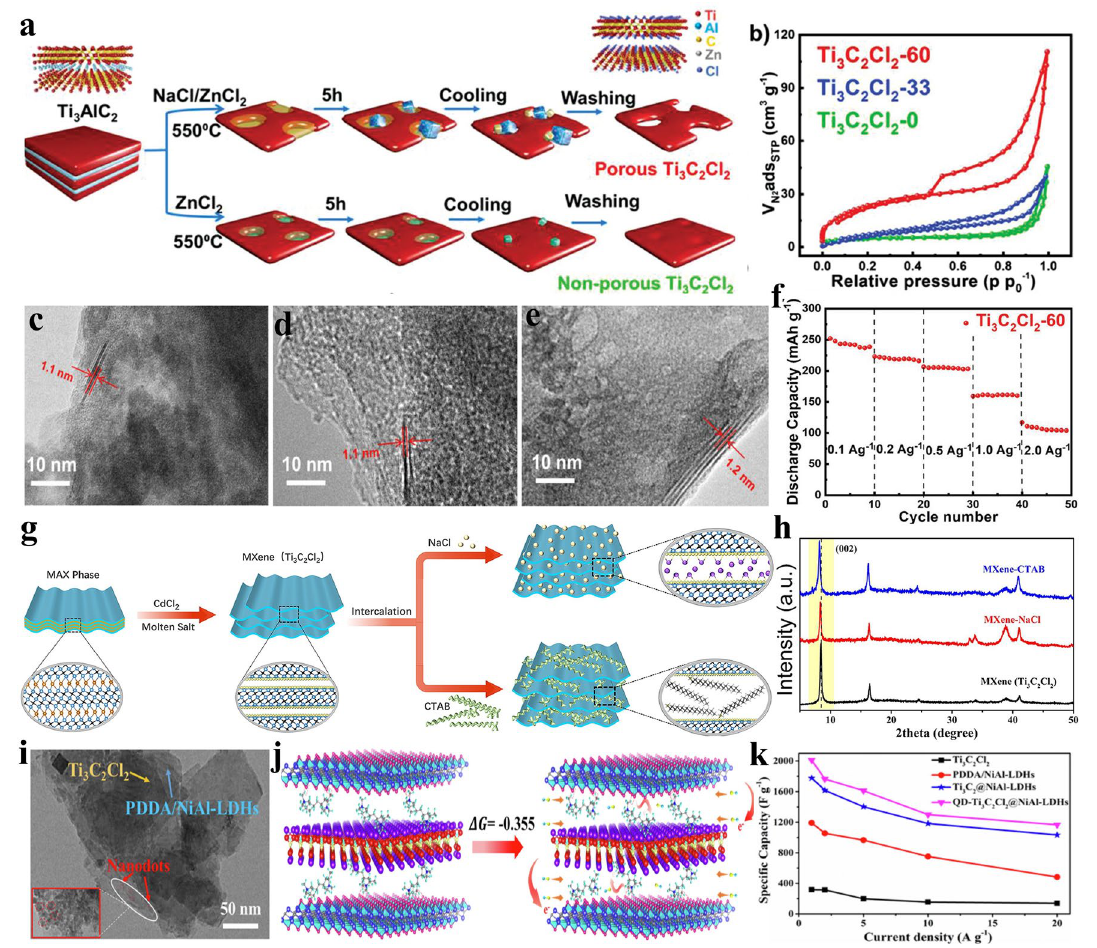
Fig. 14 a Schematic showing the preparation of in-plane porous Ti 3 C 2 Cl 2 MXene via eutectic etching. b N 2 adsorption–desorption isotherms of various MXenes. TEM images of Ti 3 C 2 Cl 2 MXene obtained by eutectic etching with c 0%, d 33% and e 60% NaCl mole percent in the NaCl/ ZnCl 2 mixture. f Rate performance of Ti 3 C 2 Cl 2 -60/graphite DIBs. Reproduced with permission from [113] Copyright 2021, Wiley–VCH. g Schematic demonstrating the preparation of MXene-NaCl and MXene-CTAB. h XRD patterns of MXene, MXene-NaCl and MXene-CTAB. Reproduced with permission from [219] Copyright 2021, Elsevier. i HRTEM image of QD-Ti 3 C 2 Cl 2 @NiAl-LDHs composites. j The free energy diagram of pseudocapacitive process on the QD-Ti 3 C 2 Cl 2 @NiAl-LDHs. k Specific capacities of the various electrodes at different current